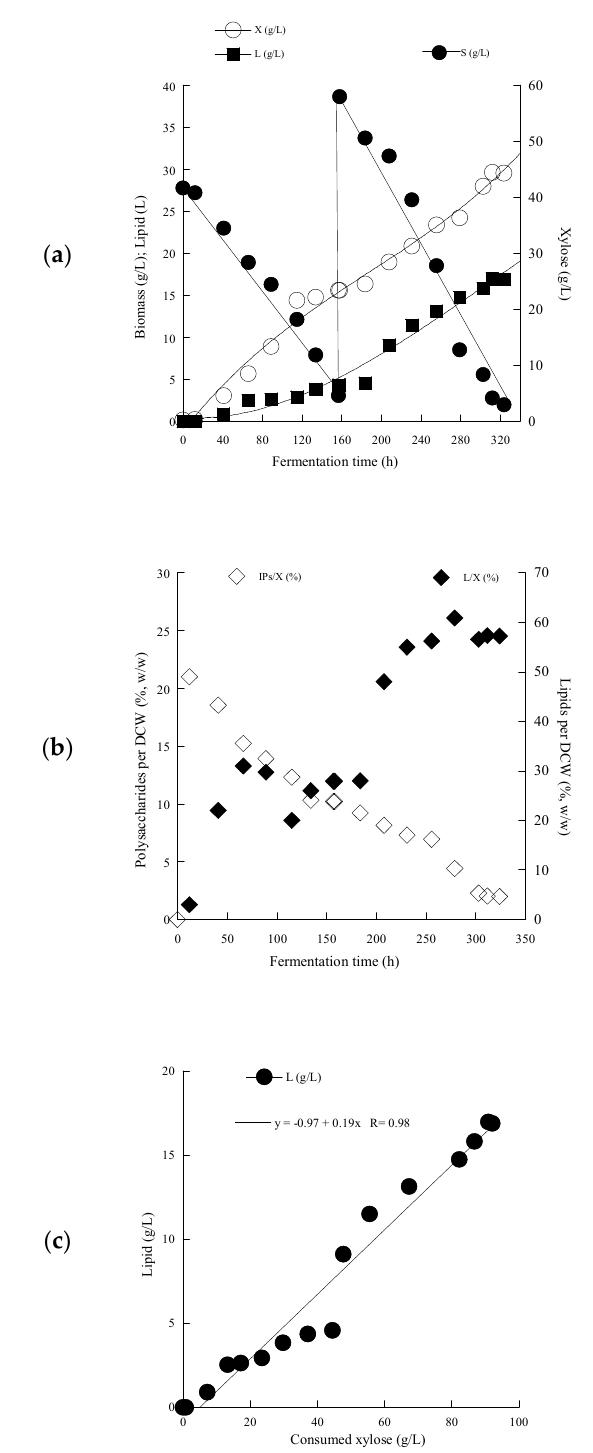
Figure 3. Kinetics of dry cell weight (DCW; X, g/L), lipids (L), and xylose (S, g/L) ( a ); polysaccharides in DCW (% w / w ) and lipids in DCW (% w / w ) ( b ); and the conversion yield of microbial lipids that were produced per unit of xylose assimilated ( c ) during fed-batch fermentations of R. toruloides NRRL Y-27012 when 20 g/L of LS were applied in fed-batch bioreactor culture. The yeast proliferation was performed on commercial-type xylose and nitrogen-limited conditions. Each experimental point is the mean value of two independent measurements.